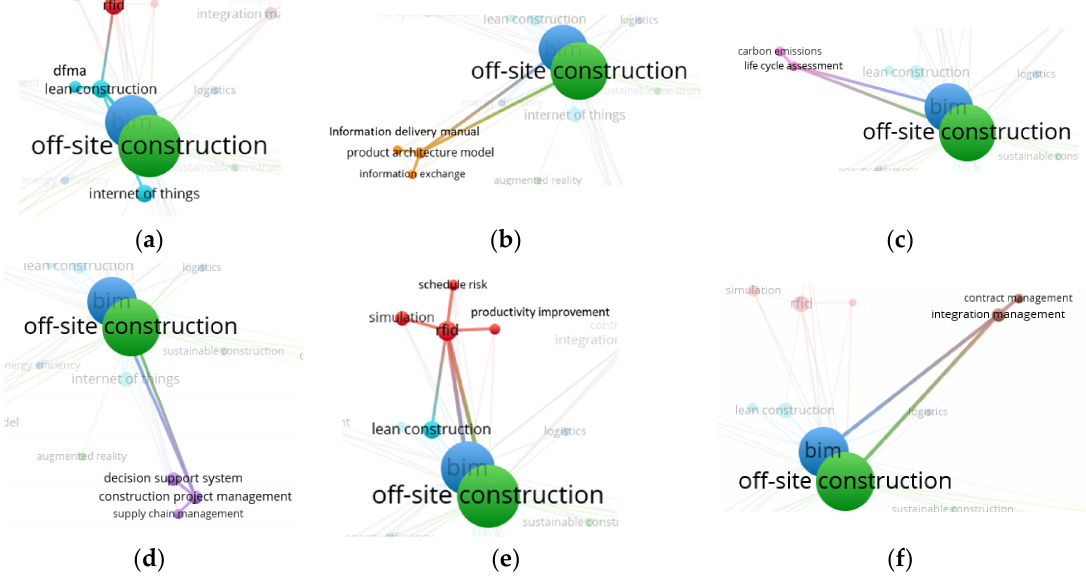
Figure 6. Research topics from clusters: ( a ) Design for manufacturing and assembly (DfMA), ( b ) information delivery and exchange, ( c ) carbon emissions, ( d ) supply chain management, ( e ) schedule risks, ( f ) integration management.